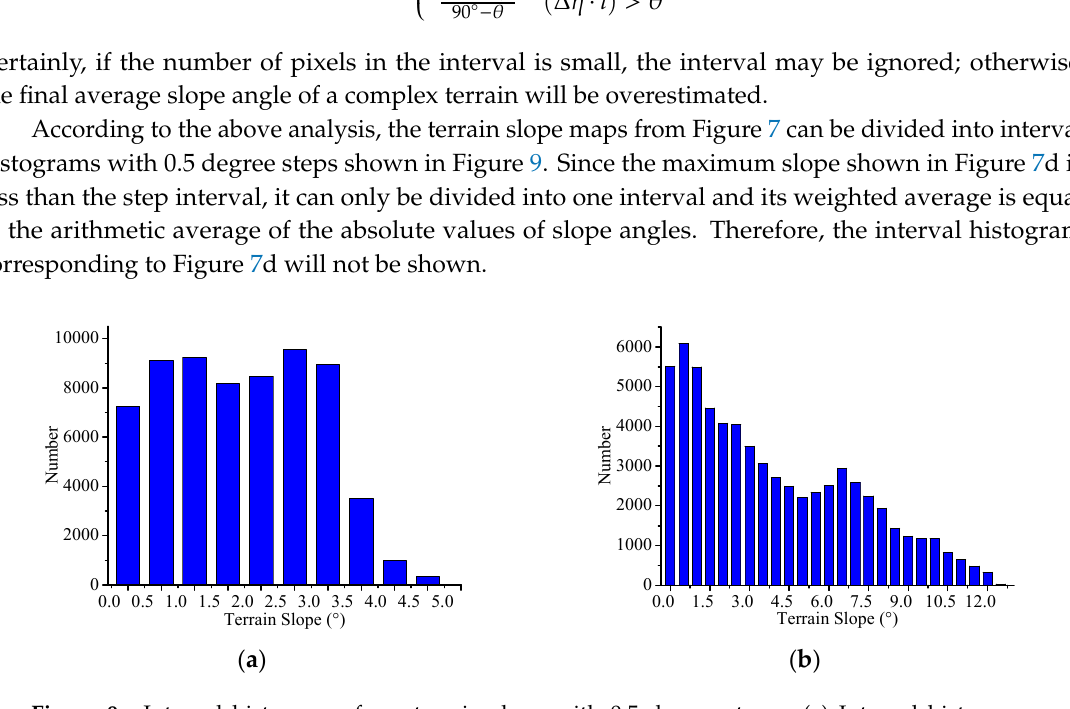
Figure 9. Interval histograms for a terrain slope with 0.5 degree steps. ( a ) Interval histogram corresponding to Figure 7(e); and ( b ) interval histogram corresponding to Figure 7(f).